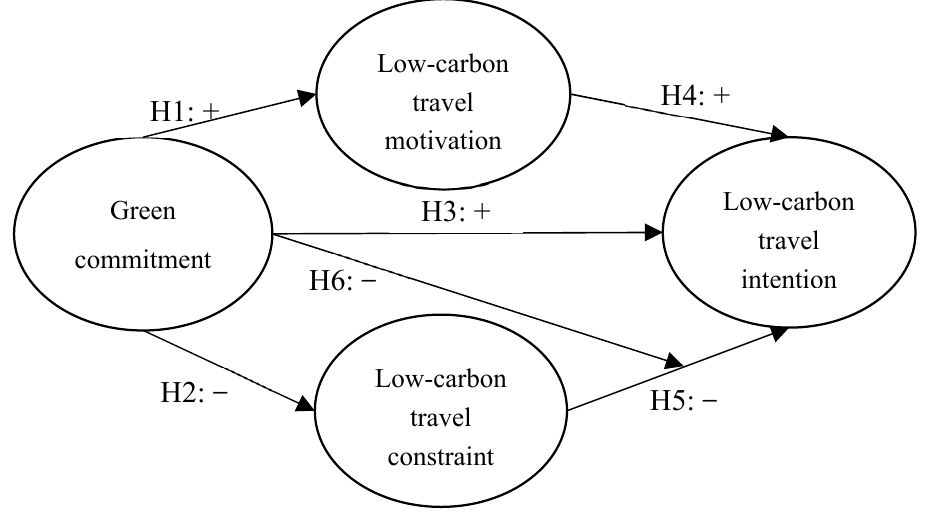
Figure 1. Diamond of this study.